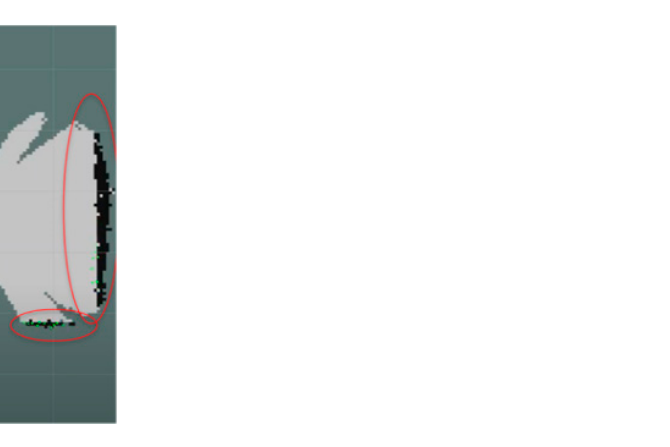
Figure 14. Observation of the reflected boundary detected behind the surface of the mirror.